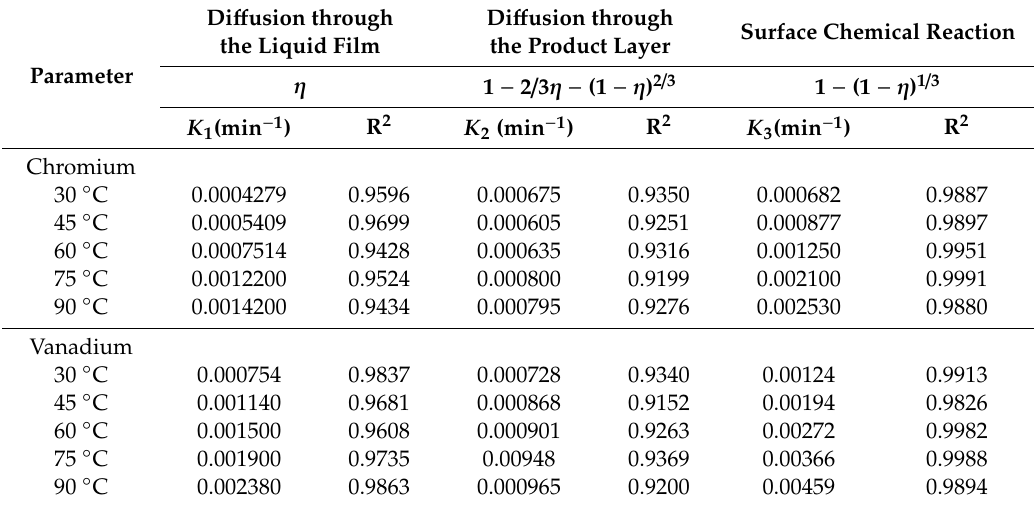
Table 2. Apparent rate constants K 1 , K 2 , and K 3 for the kinetic models and correlation coefficients. Diffusion through Diffusion through Surface Chemical the Liquid Film the Product Layer Parameter